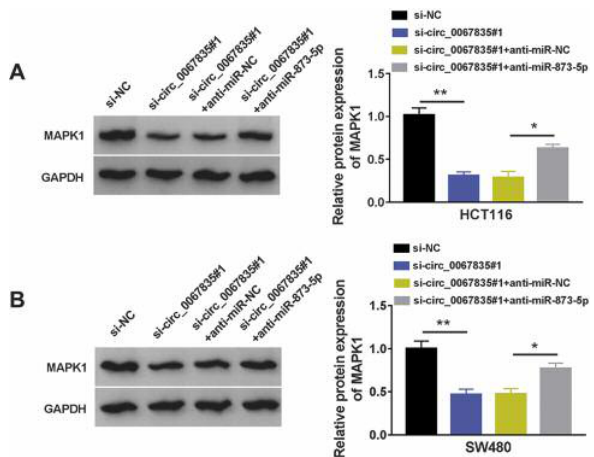
Fig. 7 Circ_0067835 positively regulated MAPK1 expression by absorbing miR-873-5p. (A-B) Western blot assay for the pro- tein level of MAPK1 in HCT116 and SW480 cells transfected with si-NC, si-circ_0067835#1, si-circ_0067835#1+anti-miR-NC or si- circ_0067835 depletion decreased the protein level of MAPK1 in HCT116 and SW480 cells, while miR-873-5p in- hibitor significantly rescued it.